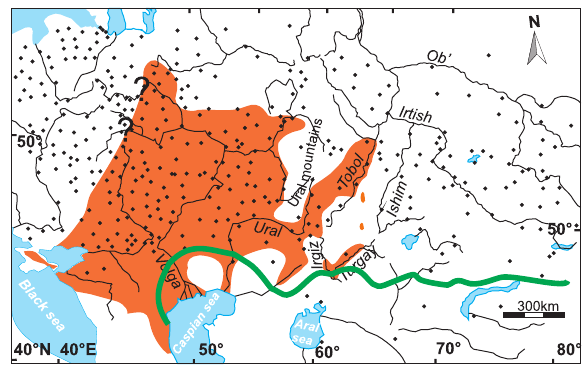
Figure 1. Range of the Pallas’ spadefoot, weather stations and the boundary of the desert zone. Geographic range of the Pallas’ spadefoot (shaded), weather stations with soil thermometers (black dots) and the northern boundary of the desert zone (green